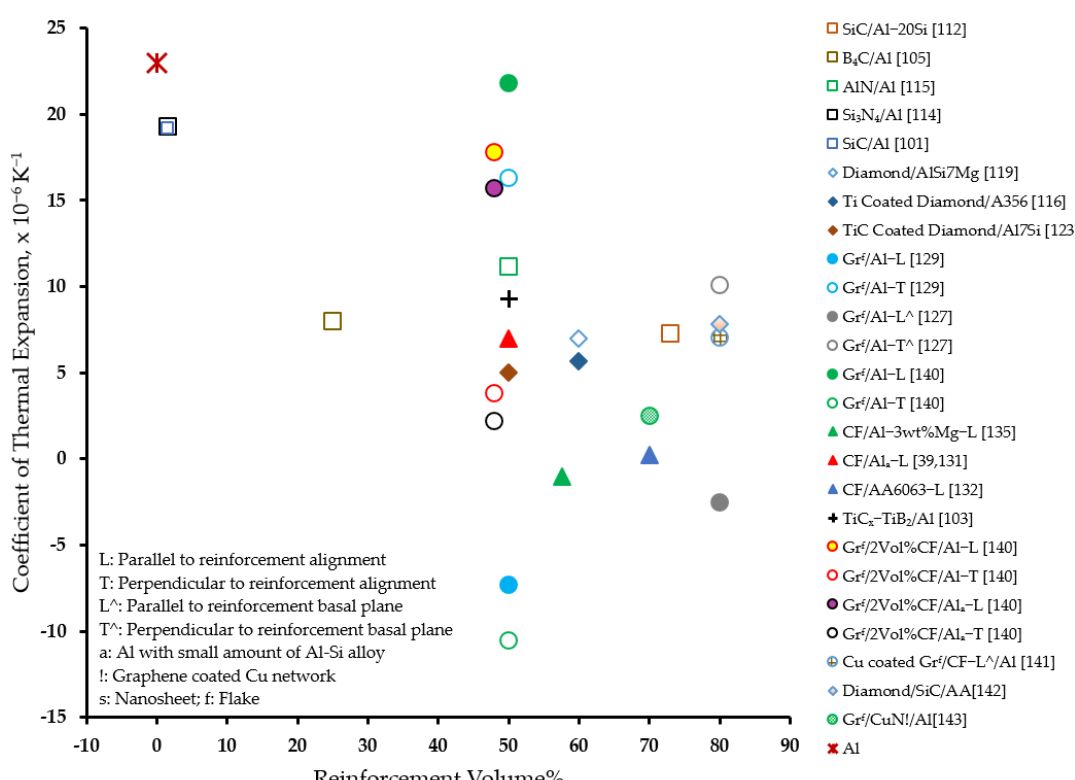
Figure 11. Effect of reinforcement on the coefficient of thermal expansion of AMCs.